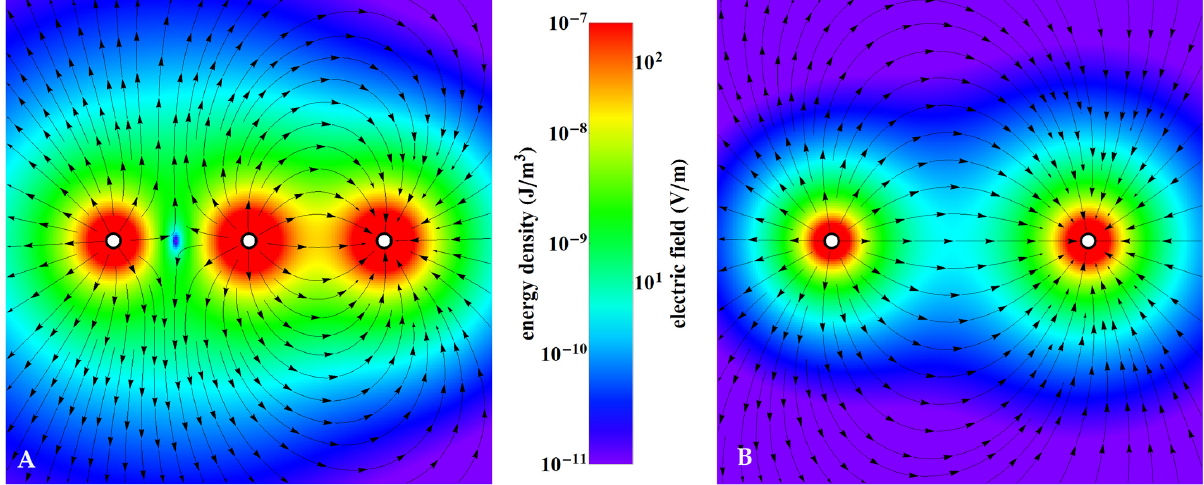
Figure 2. The geometry of electric fields: ( A )—three-electrode systems (Zn, Bi, Cu), ( B )—two-electrode systems (Cu, Zn), visible colors show the energy density. A finite element modeling (FEM) package was used to create models of the electric field: see Spisak et al., 2016, prepared by Alcor R & D Center, unpublished report, project No. POIR.01.01.01-00-0004/15.